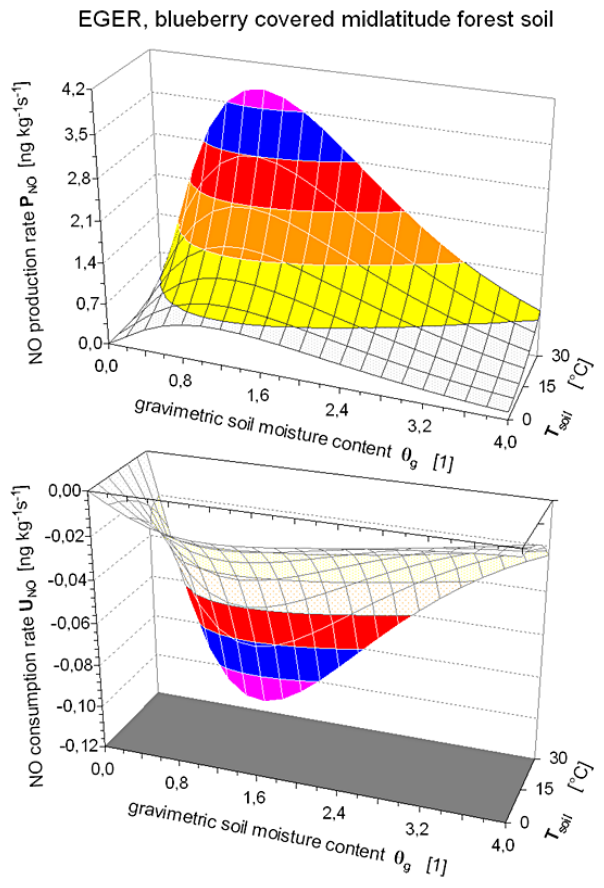
Figure 22. Two-dimensional illustration of NO production rate P NO (θ g , T soil ) and NO consumption rate U NO (θ g , T soil ) for the EGER blueberry soil. Light shaded areas represent P NO and U NO values which fall short of corresponding data rejection criteria (i.e. minimum detectable levels of P NO and U NO ; see Sect. 5.2). Table 2.